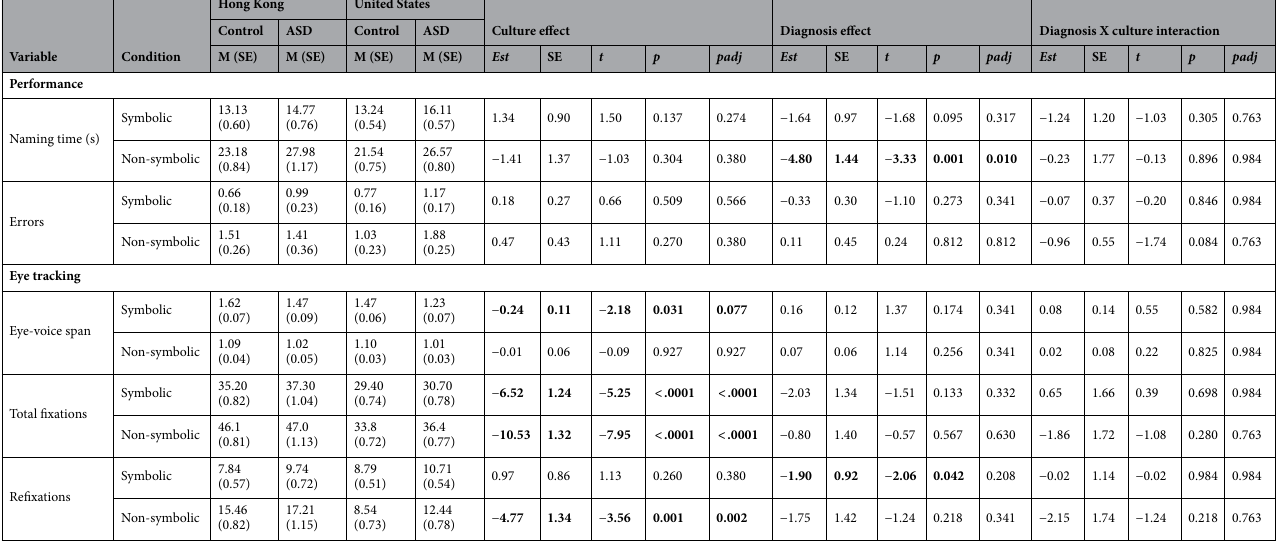
Table 2. Summary of results. Bold indicates significance p < .05; padj included Benjamini–Hochberg correction at a false discovery rate of .10.